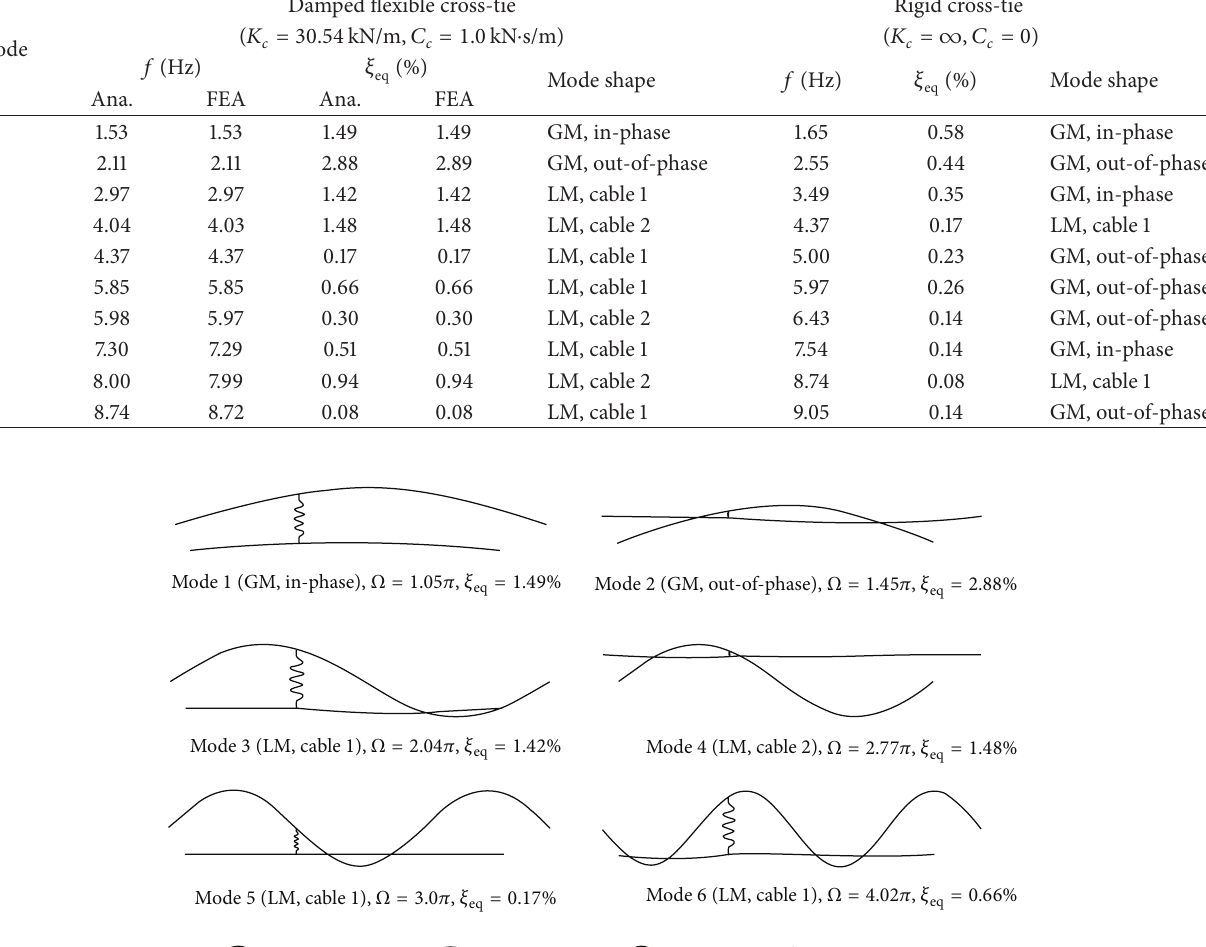
Table 4: Comparison of modal properties of an asymmetric DMT two-cable network with damped flexible or rigid cross-tie at 𝜀 = 1/3 . Damped flexible cross-tie Mode